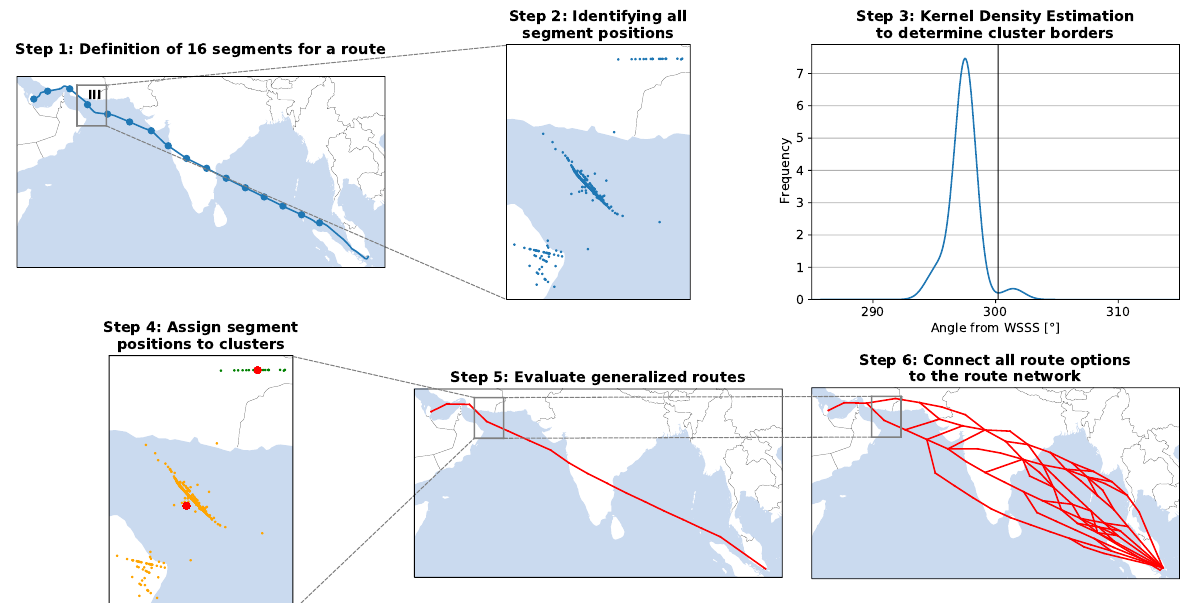
Figure 7. Evaluation of a generalized route network based on historic flight